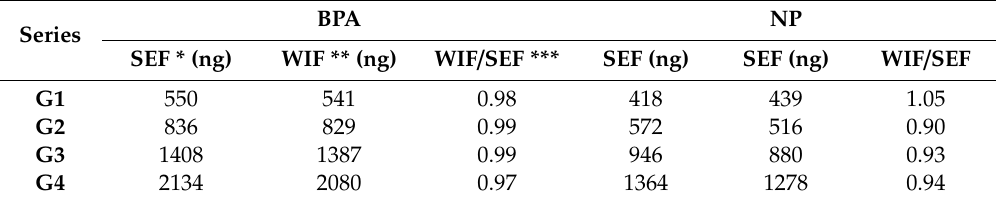
Table 4. The mass balance between sediment efflux and water influx.